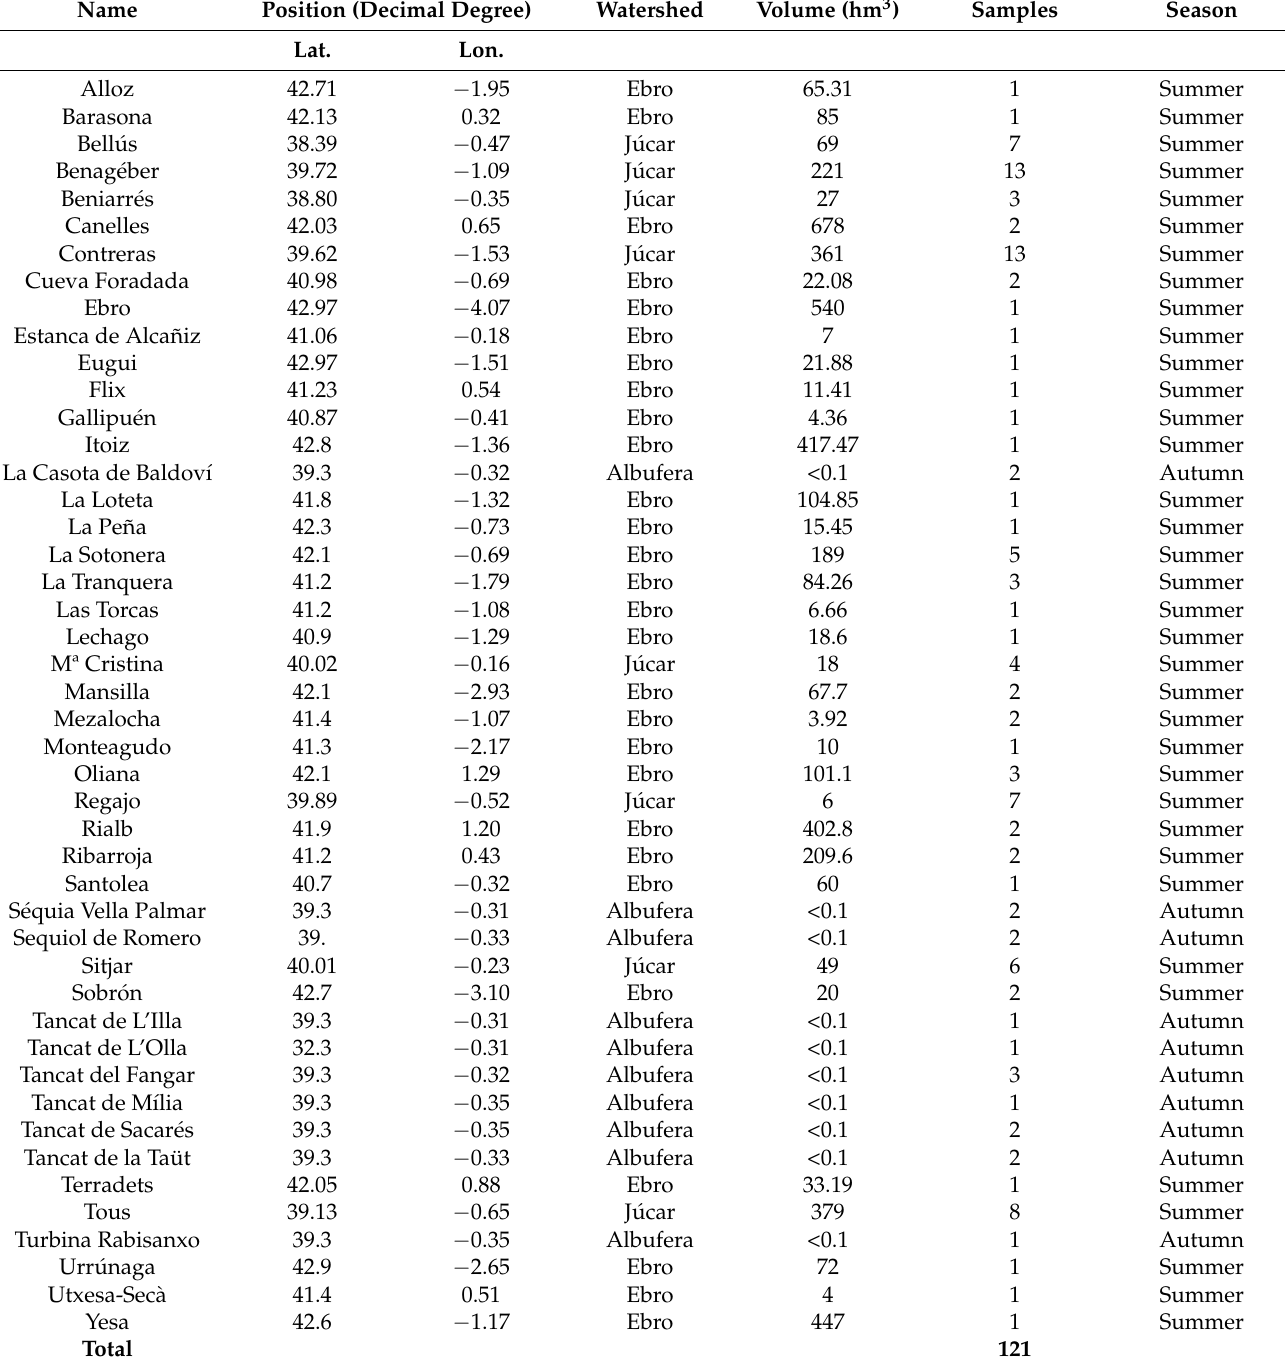
Table A1. Summary of sampled water bodies. Abbreviations: lat.: latitude; lon.: